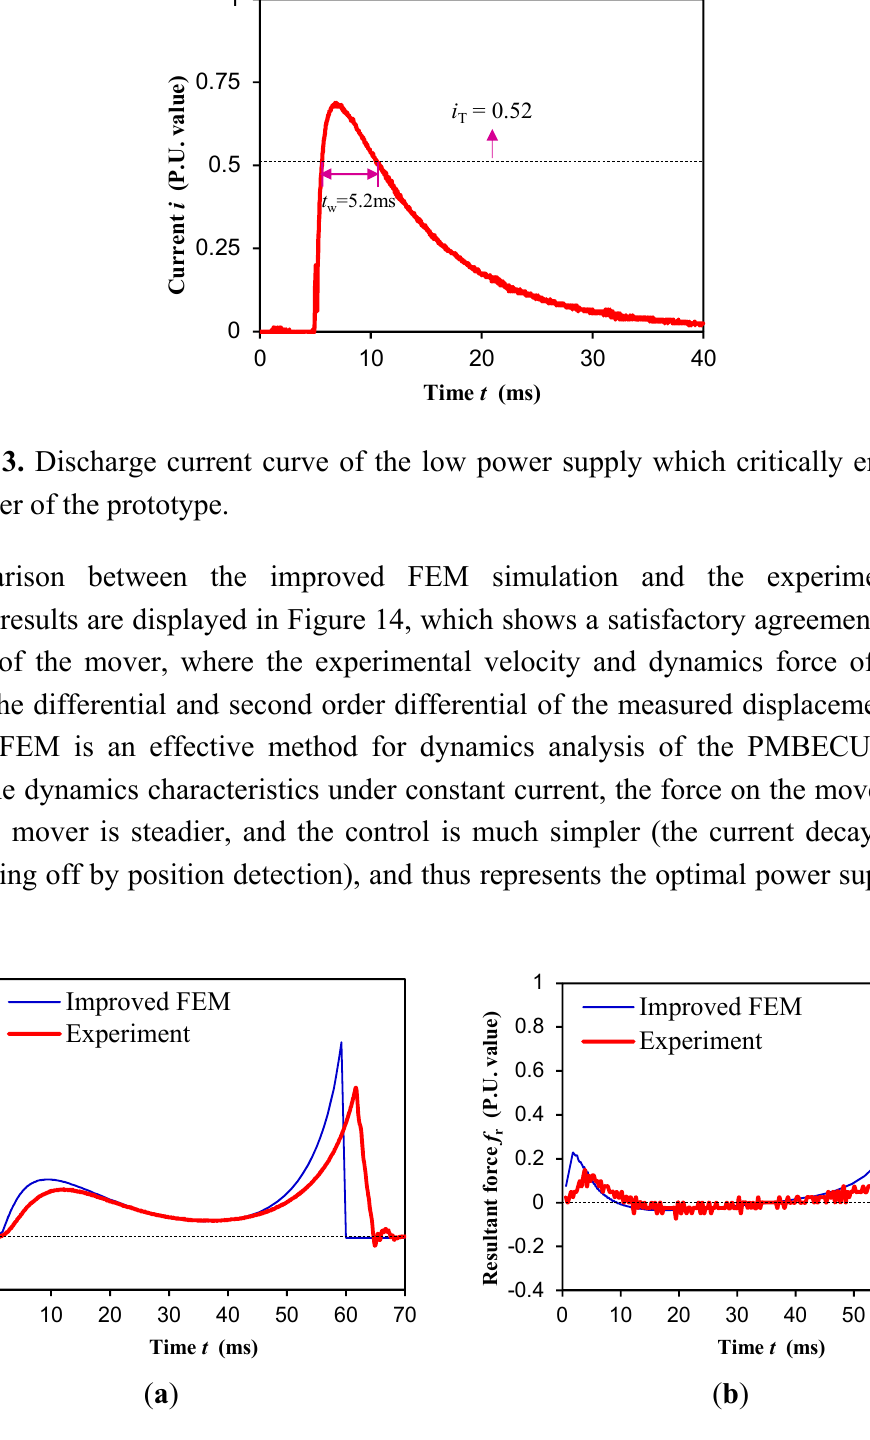
Figure 14. Comparison of dynamics characteristics under low power pulse supply. ( a ) Velocity; ( b ) Resultant horizontal